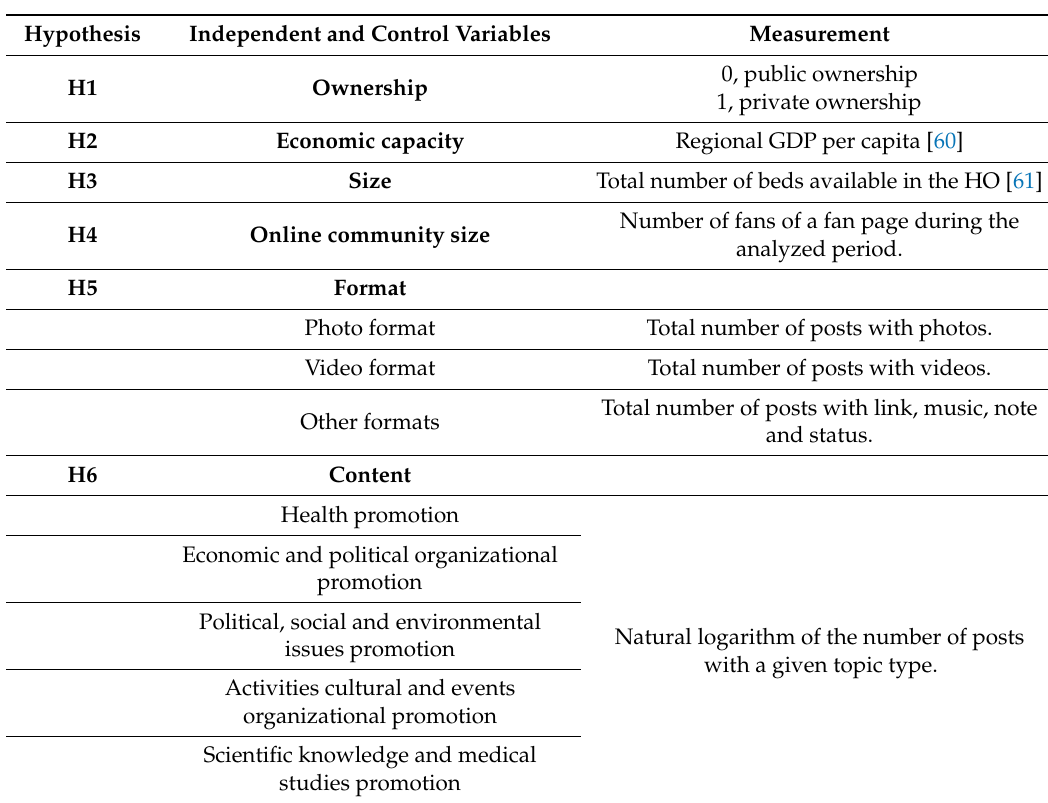
Table 3. Independent variables.